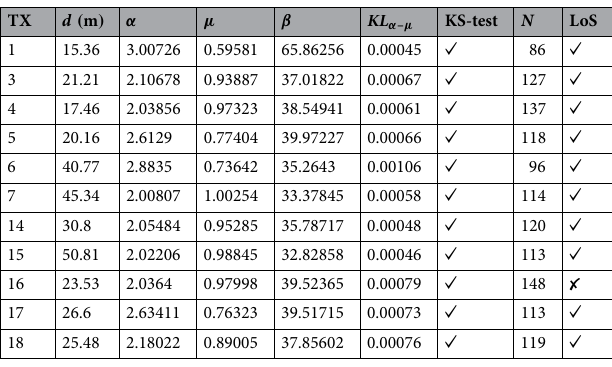
Table 3. Airport links parameters of the α – µ distribution.